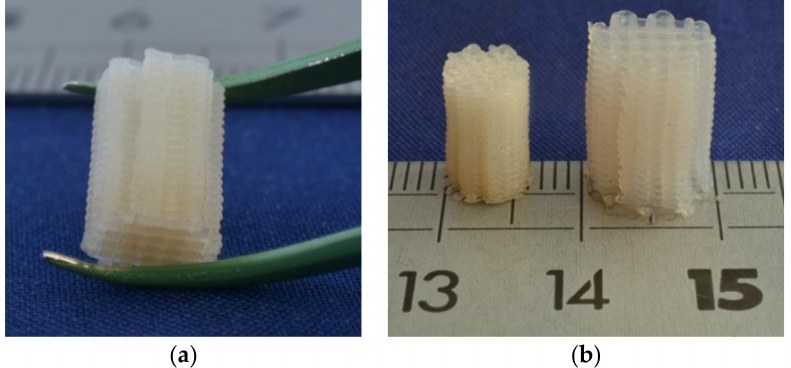
Figure 7. Designed structure prepared from TPU-(PCL 5 -PEG 10 -PCL 5 ) multi-block copolymer by fused deposition modelling: ( a ) Structure in the dry state and ( b ) comparison of the structure in the dry state and in the hydrated